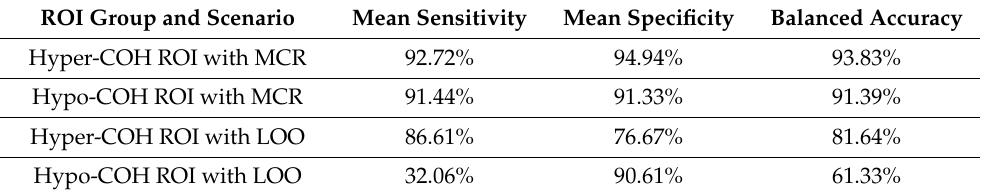
Table 2. Effectiveness of ROI group selection in different testing protocols. The results are averaged from 20 tests in both scenarios.